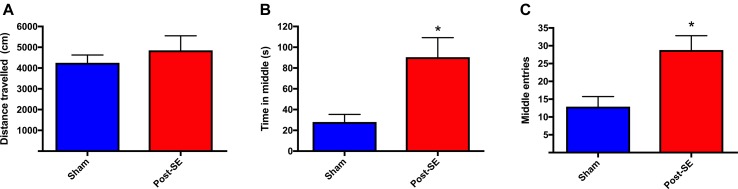
Distance travelled in an open-field. No difference in total distance travelled during open-field session was observed between groups (A). Post-SE rats spent more time in the middle (B) and had significantly more middle entries (C) when compared to sham. Bars represent means ± SEM and * represents p < 0.05.